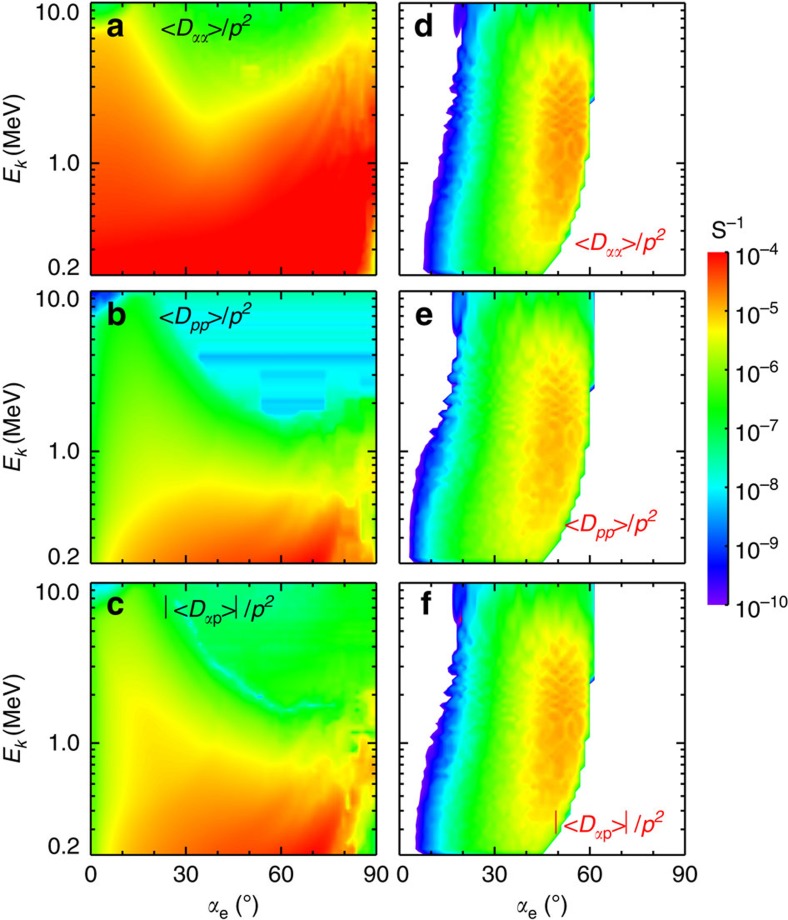
Diffusion rates.Bounce-averaged pitch angle (〈Dαα〉, (a,d)), momentum (〈Dpp〉, (b,e)) and cross (〈Dαp〉, (c,f)) diffusion rates (in unit of s−1) for resonant interactions between chorus (left) or MS (right) wave with electrons. Diffusion rates cover an entire region of pitch angles 0°–90° for chorus but a limited region 30°–60° for MS waves. Combination of chorus and MS waves leads to efficient acceleration of electrons between 2 and 3.6 MeV at medium pitch angles 30°–60° and high pitch angles up to 90°, yielding the resultant butterfly distribution on a timescale comparable to 10 h.